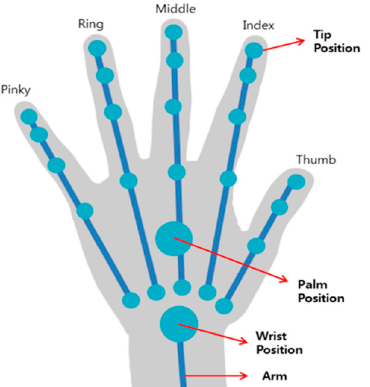
Figure 2. LMC wrist joint recognition range. LMC recognizes the upper extremity in real-time and makes it possible to know the movement pattern of the user.